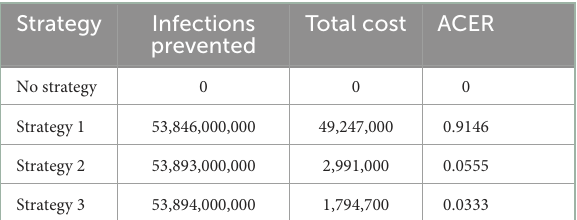
TABLE 4 Total infections prevented, total costs, and ACER for strategies 1, 2, and